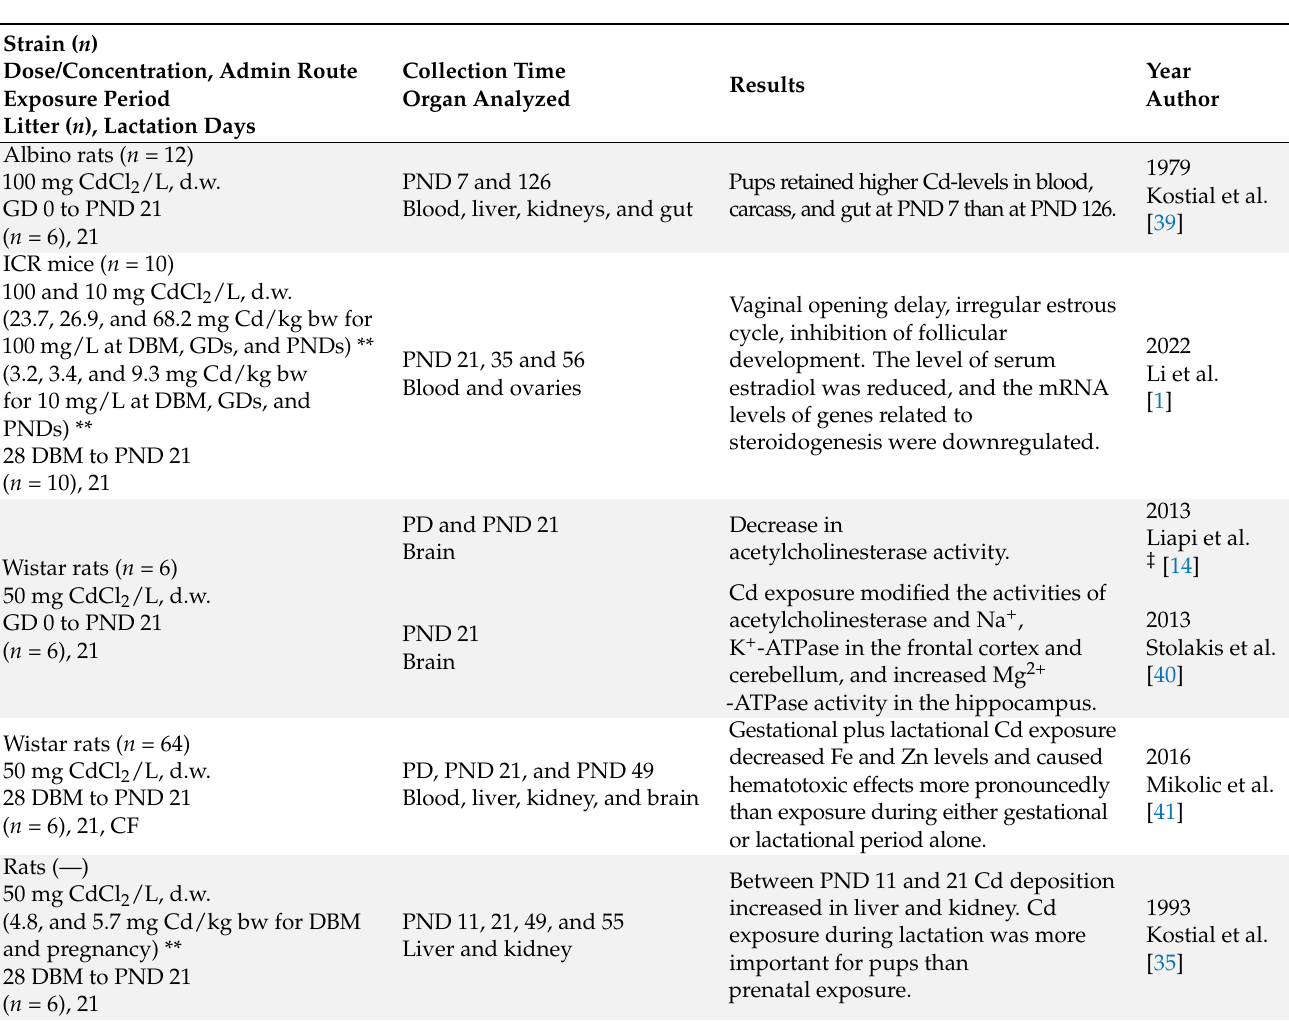
Table 3. Cd exposure during pregnancy–lactation period. Experimental data are ordered by dose/concentration of